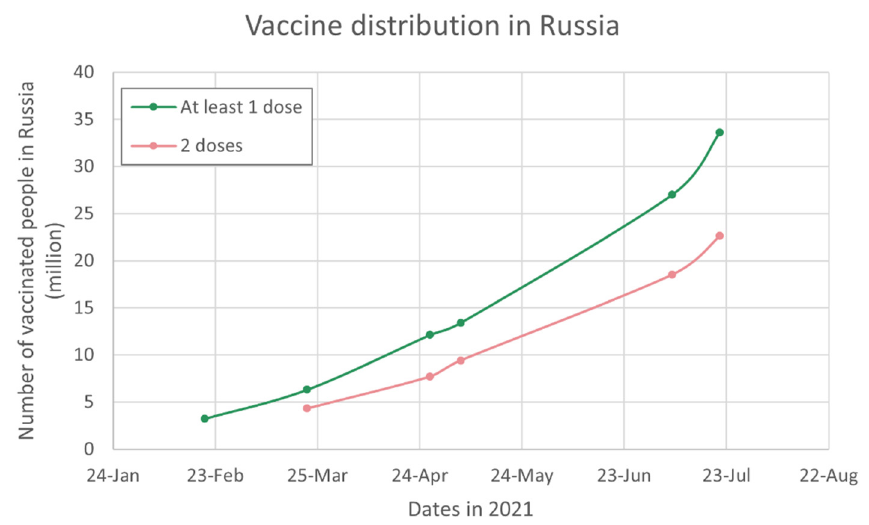
Figure 2. Number of vaccinated people in Russia as a function of time (data collected from official communications from the Russian government [4,5,30–32]).